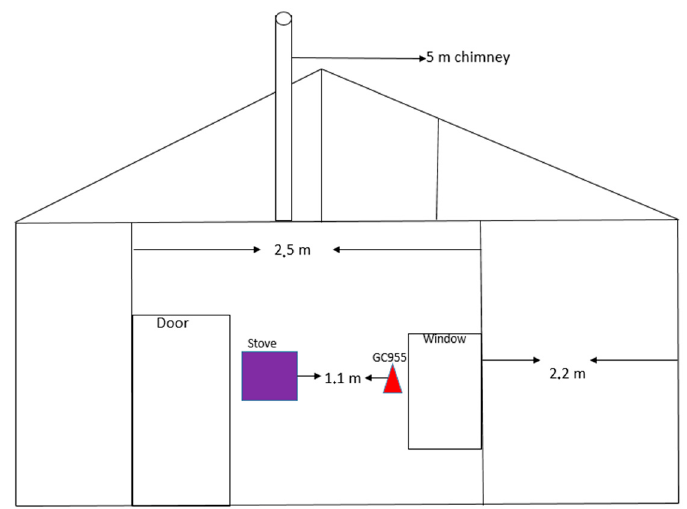
Figure 1. Schematic diagram of a traditional corrugated iron house in a typical South African informal settlement, stove, and GC955 sampling inlet. (Not drawn to scale).